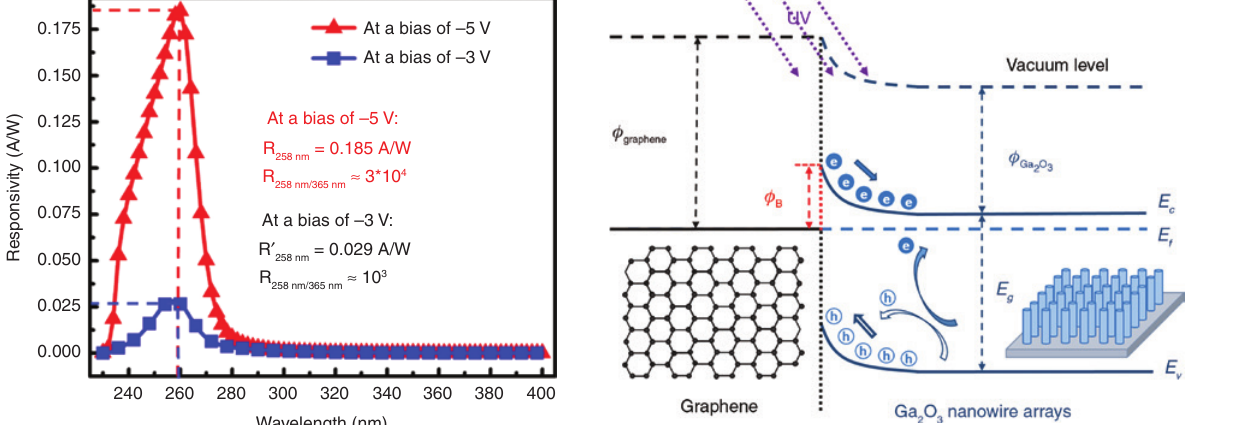
Figure 4: Spectral response of PDs based on the graphene/vertical Ga O nanowire array heterojunction at the bias of −3 and −5 V. 2 3